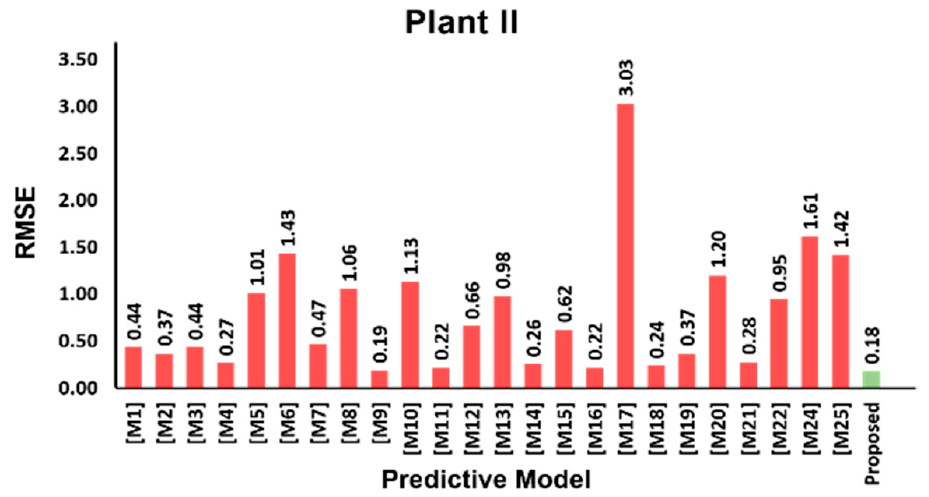
Figure 13. Comparison of RMSE values for existing and proposed models for predicting dephosphorization in steel for Plant II.